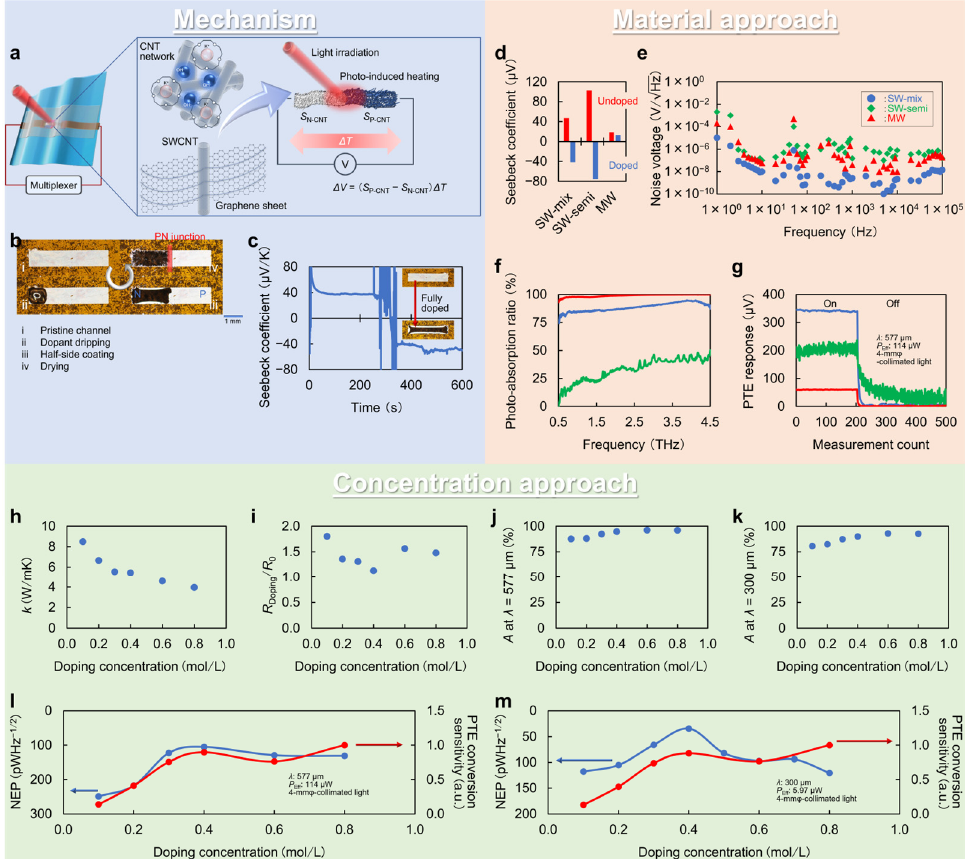
Figure 4. PTE effect in the CNT film channel’s PN-junction. ( a ) Operating mechanism. ( b ) Process of the N-type chemical carrier doping. ( c ) Change in the Seebeck coefficient of the CNT film before and after doping. ( d ) Changes in the Seebeck coefficients, ( e ) the noise voltage, and ( f ) the photo-absorption ratio in sub-THz frequency region of the device channels for different CNTs types. ( g ) Comparison of the PTE responses of each type of the CNT-film-based photo-detector. ( h ) Changes in the thermal conductivity, ( i ) electrical resistance, and photo-absorption ratios in ( j ) sub-THz fre- quency region and ( k ) THz frequency region. ( l ) Changes in the NEP values and PTE conversion sensitivities in sub-THz frequency region and ( m ) THz frequency region. ( a – m ): Reproduced with permission from [25] Copyright 2021, the authors, published by Springer Nature.